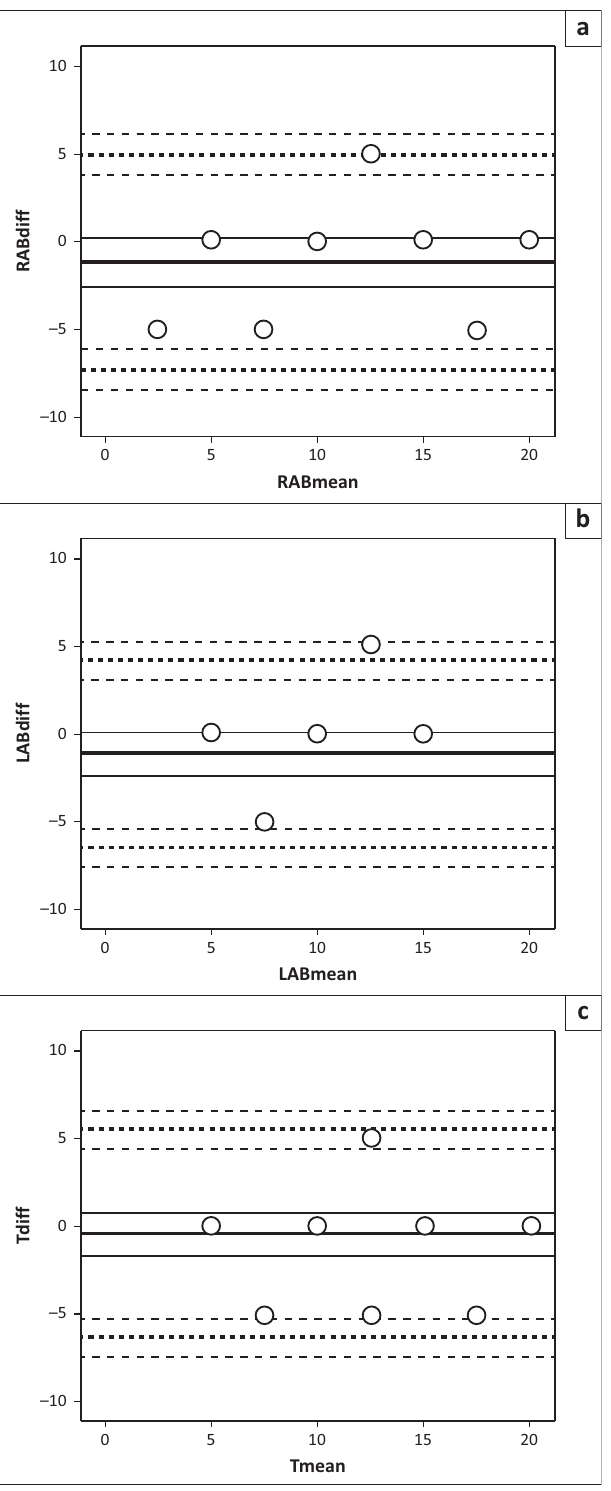
Note: The solid, bold lines represent mean difference values with the nearby solid lines representing the standard error for those means. The broken, bold lines represent upper and lower limits of agreement for the mean difference values with the nearby broken lines representing the standard error for those limits. RABdiff = right ear difference scores between Test halves A and Test B, RABmean = right ear mean scores between Test halves A and Test B, LABdiff = left ear difference scores between Test halves A and Test B, LABmean = left ear mean scores between Test halves A and Test B, Tdiff = right ear difference scores between Test times 1 and 2, Tmean = right ear mean scores between test times 1 and 2. FIGURE 1: Bland and Altman plots to examine the consistency of the isiZulu SRT test results. Internal consistency was considered by comparing scores between Test halves A and Test B for the right ear ([plot] a) and left ear ([plot] b). External consistency was considered by comparing whole test scores between Test times 1 and 2 for the right ear ([plot]